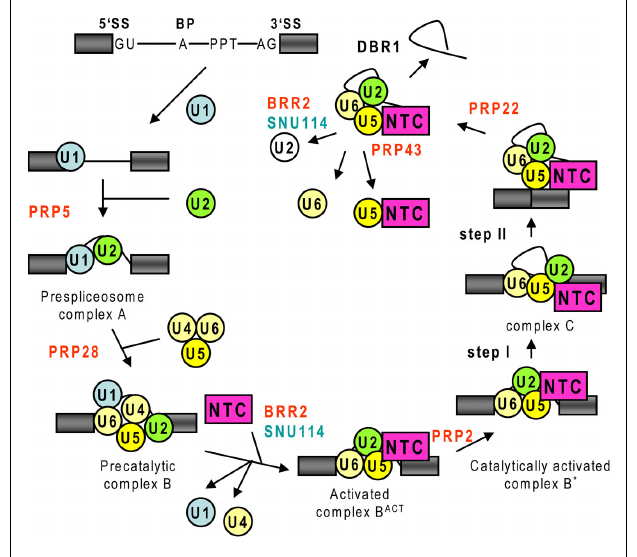
FIGURE 2 | Schematic presentation of spliceosomal assembly and catalytic cycle. The scheme is drawn according toWahl et al. (2009) indicating the assembly phase specific regulatory roles of key ATP-dependent DExH/D-box RNA helicases (in red) and the spliceosome-activating NTC complex. 5 (cid:2) and 3 (cid:2) splice site (5 (cid:2) SS and 3 (cid:2) SS), branch point (BP), and polypyrimidine tract (PPT). Exons are indicated by gray boxes, while thin black lines show intron and intron